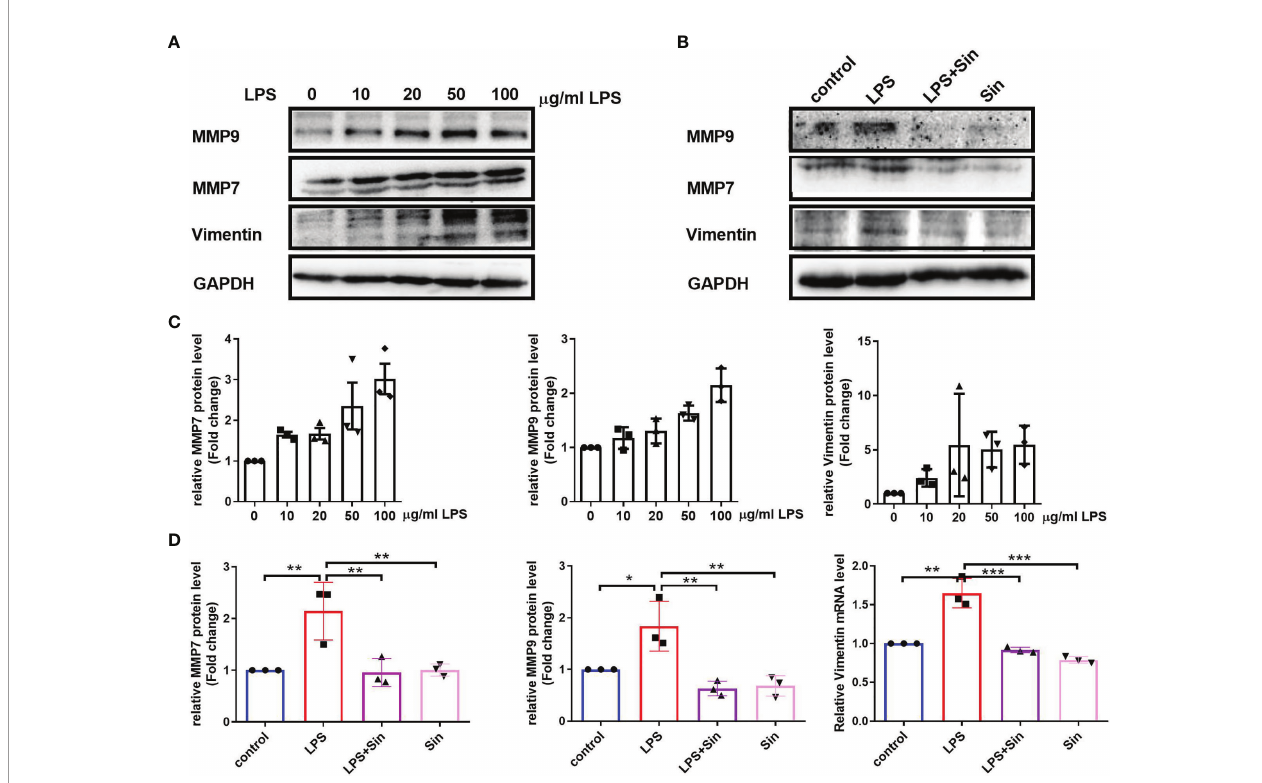
FIGURE 2 | Sin inhibited EMT in LPS-exposed human airway epithelial cells. (A) The 16HBE cells were seeded in a 6-well plate and stimulated with LPS at concentrations of 0, 10, 20, 50, 100 m g/mL for 72 h. Protein levels of MMP9, MMP7, and vimentin were determined using Western blotting. (B) The 16HBE cells were seeded in a 6-well plate and divided into four groups: control (untreated), LPS (100 m g/mL), LPS with Sin (100 m g/mL and 200 m g/mL, respectively), and sin (200 m g/mL) groups. The cells were incubated for 72 h to perform Western blotting. (C, D) Statistical analysis of the gray values of each protein normalized to GAPDH. The data are presented as mean ± SEM from three independent experiments. The one-way analysis of variance followed by Dunnett ’ s Multiple Comparison Test was used. *p < 0.05. **p < 0.01. ***p <